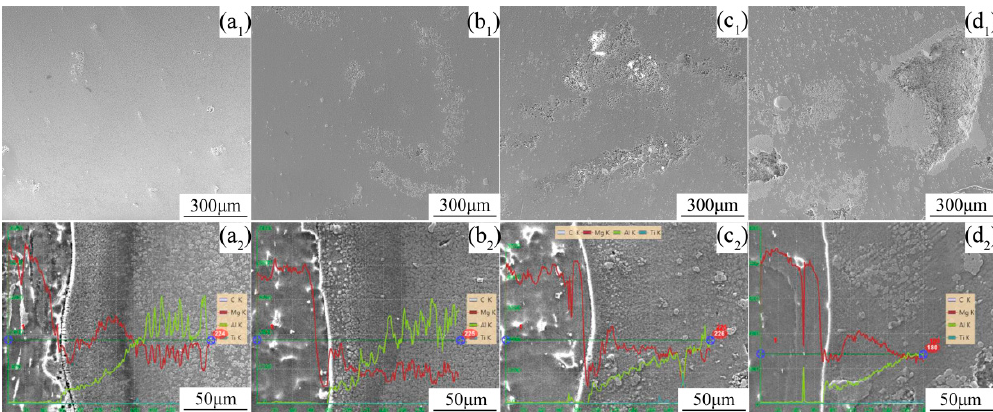
Figure 6. SEM morphology of coatings middle area and fusion zone, and microhardness distribution of the composite coating: ( a1 , b2 ) Al+5wt%TiC; ( b1 , b2 ) Al+10wt%TiC; ( c1 , c2 ) Al+15wt%TiC; ( d1 , d2 ) Al+20wt%TiC.